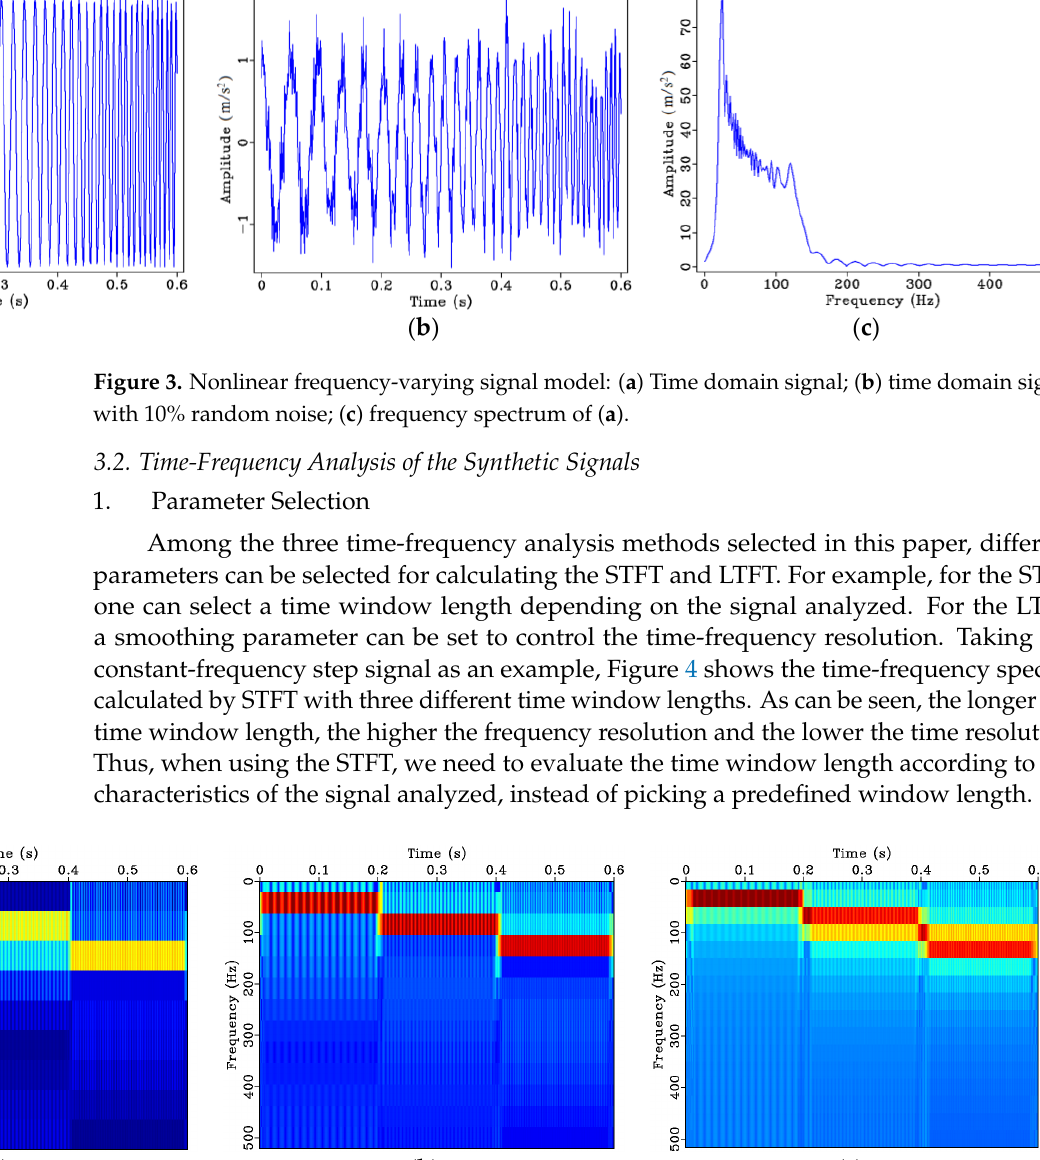
( c ) Figure 5. LTFT time-frequency spectra with different smoothing radii: ( a ) 11; ( b ) 15; and ( c ) 19 points. The jet colormap is used where blue and red represent low and high frequency magni- tudes, respectively. 2. Constant-Frequency Step Signal Next, the three synthetic signals are processed using the STFT (window length = 21 points), ST, and LTFT (smoothing radius = 15 points). Figure 6a,b shows, respectively, the time-frequency spectra of the constant-frequency step signal and its noisy version processed by the STFT. It can be seen that this method can effectively capture all three frequency components. However, owing to the limitation that the frequency resolution is relatively low, if a wider time window is chosen to increase the frequency resolution, the time resolution capability would be lost (see discussion around Figure 4). Figure 6c,d shows the time-frequency spectra of the S transformed signals. The ST offers better time- frequency resolution, especially at low frequencies, while the time-frequency resolution is lower at higher frequencies. It can further be observed that the ST cannot effectively capture the distinct changes in frequency. In addition, like the STFT, the ST spectrum shows notable high-frequency noise for the noisy version of the signal (Figure 6b,d). Figure 6e,f is the result of the LTFT, which has high-resolution regardless of time direc- tion and frequency direction. Not only can it effectively represent the changes at the step